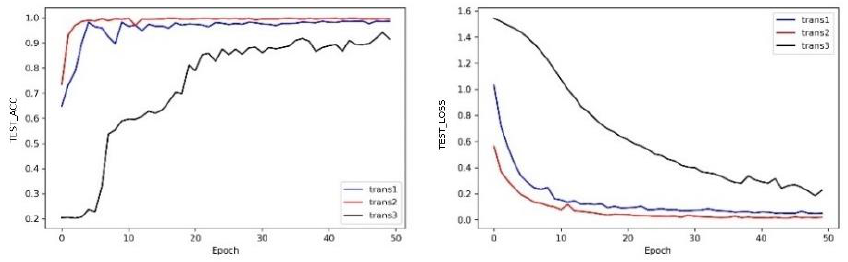
Figure 12. Comparison of three transfer methods under 0.375 data size.